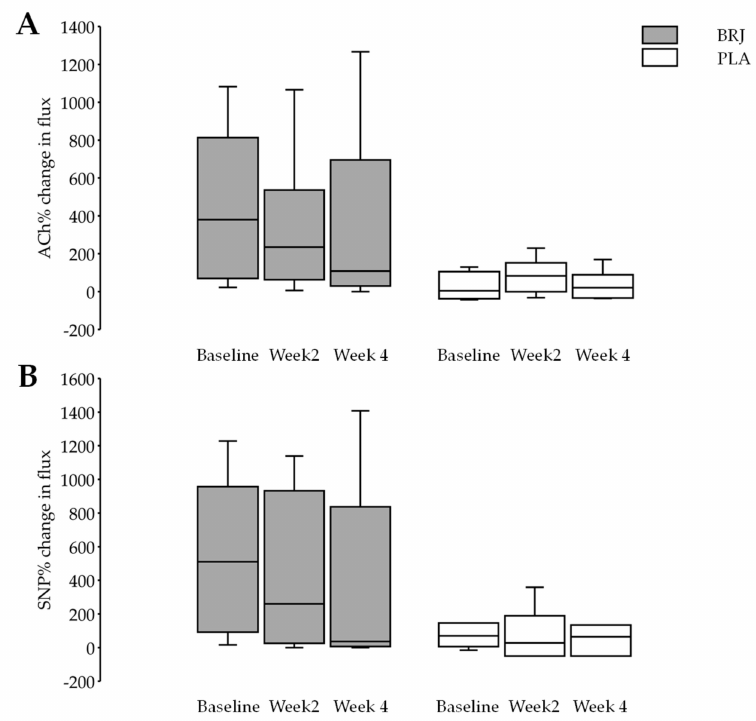
Figure 4. The e ff ect of treatments on laser Doppler imaging (LDI) with iontophoresis is over four weeks ( n = 18). Log-transformed data was used for all analyses, as the untransformed data was not normally distributed. Untransformed data expressed as median (IQR). ACh = acetylcholine; LDI = laser Doppler imaging; IQR = interquartile range and SNP = sodium